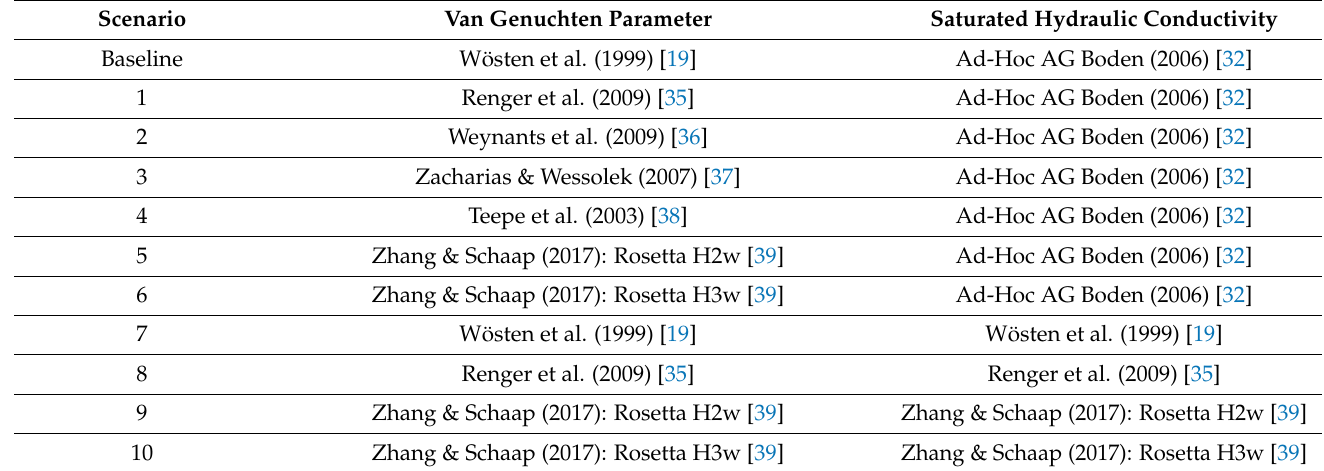
Table 3. Scenario definition: combinations of PTFs to determine the van Genuchten parameters ( θ sat , θ res , α , n) and the saturated hydraulic conductivity (K sat